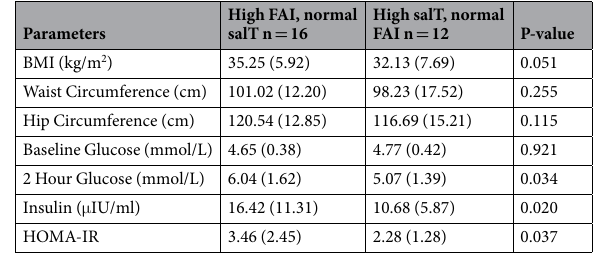
Table 3. Comparison of PCOS women with an elevated isolated free androgen index versus an elevated isolated salivary testosterone. Values in (mean (SD)). salT – salivary testosterone. FAI – free androgen index. HOMA-IR – homeostatic model assessment – insulin resistance. BMI – Body Mass Index . Comparison of PCOS women who had an elevated FAI alone (salT not elevated) and those with an elevated salT (FAI not elevated). As shown in this analysis, women with a raised FAI alone compared to the raised sal T alone had a more metabolic